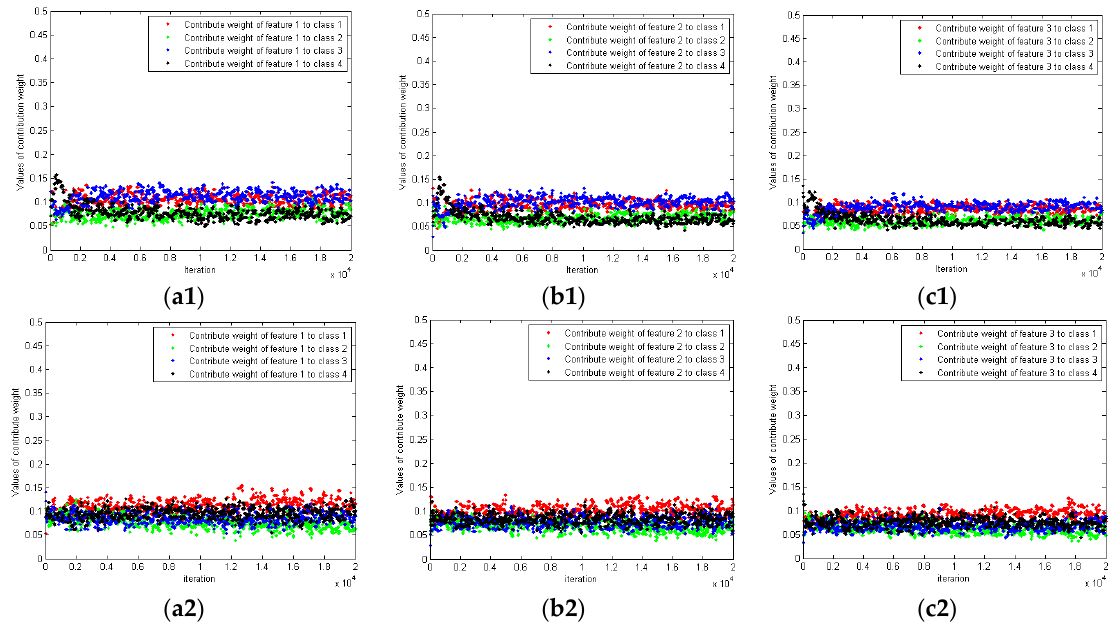
Table 3. Approximate feature weight values for a simulated SAR image.